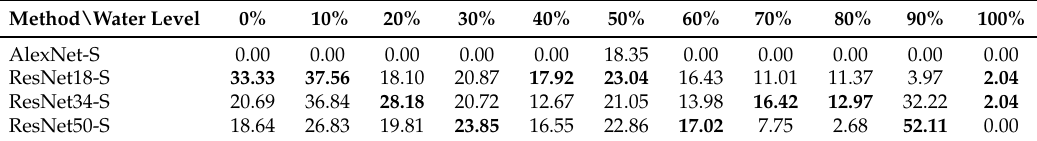
Table A3. Per-class F1 score for the CNNs trained from scratch—Reg2Class10 training setting. Method\Water Level